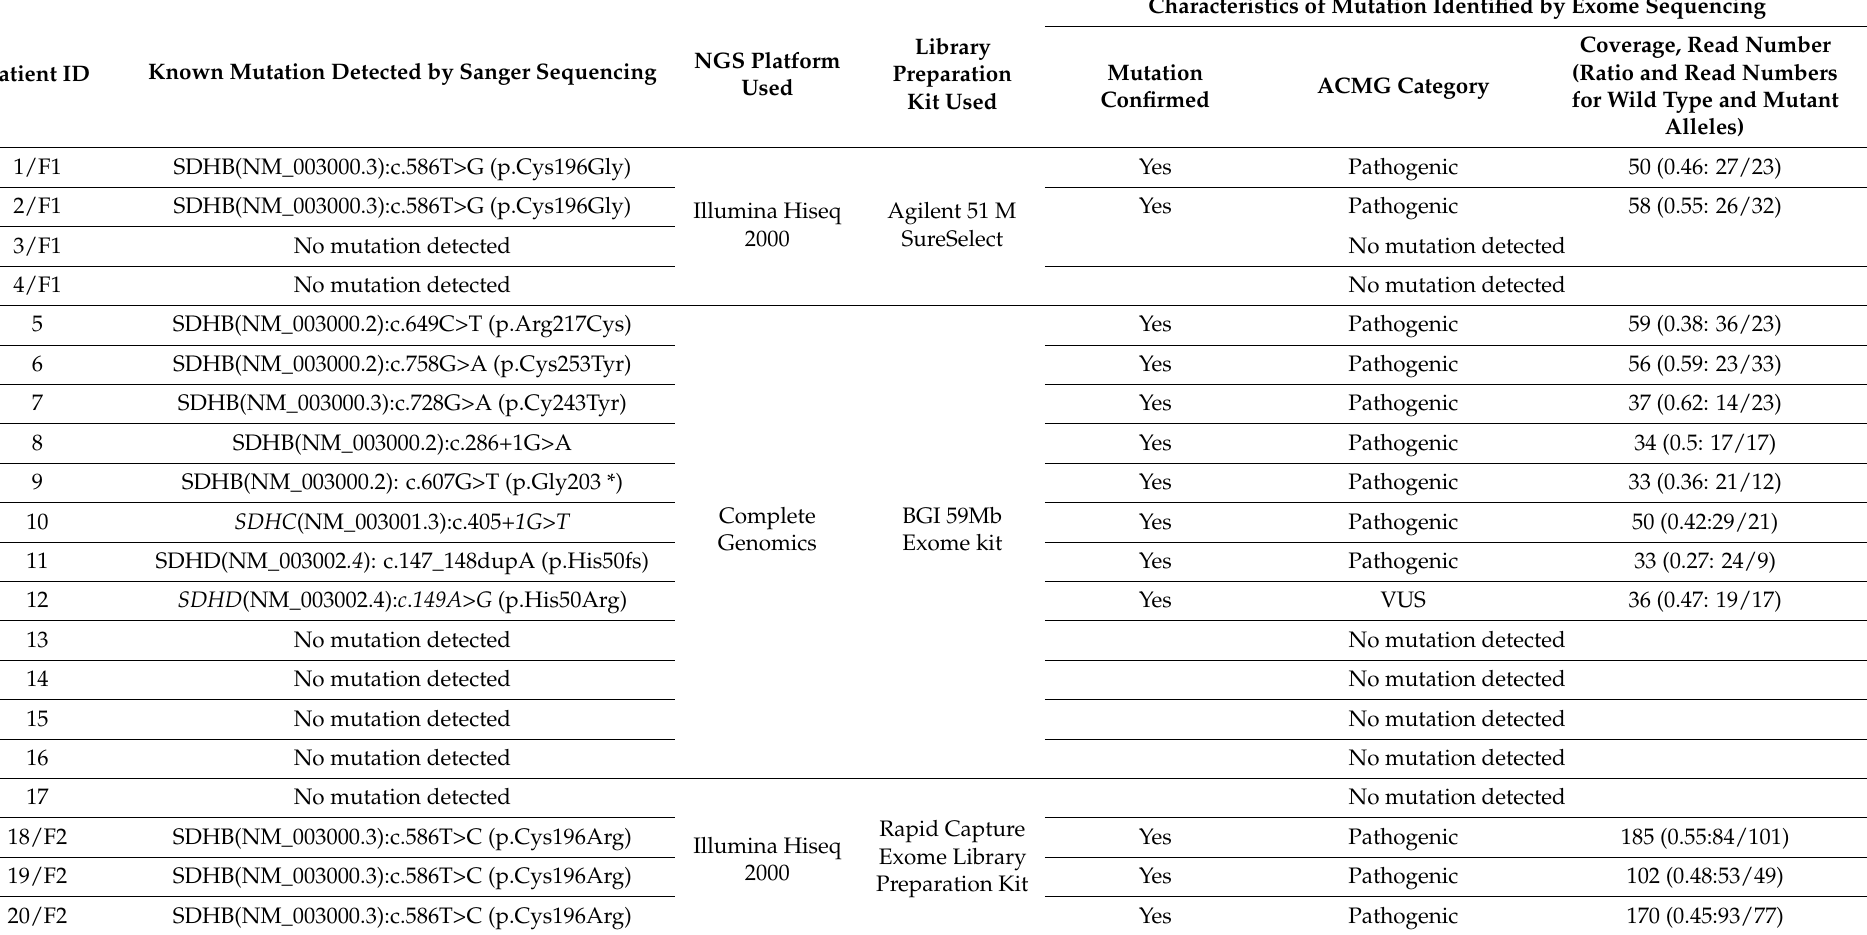
Table 1. Genetic alterations of samples used for analytical testing of